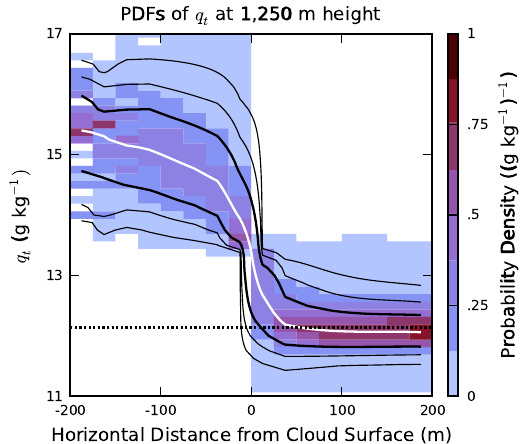
Fig. 16. Variation in the probability density function of total specific water q t at 1250m height with distance from the nearest cloud sur- face. Probability density functions are taken at 25m distance inter- vals, to match the model grid spacing. Negative distances represent points inside the cloud. Black lines show contours of the cumulative distribution functions of each variables at the 0.01, 0.05, 0.16, 0.84, 0.95, and 0.99 levels, from bottom to top; white line shows the 0.5 level of the cumulative distribution function. Horizontal dotted line shows the domain-average specific